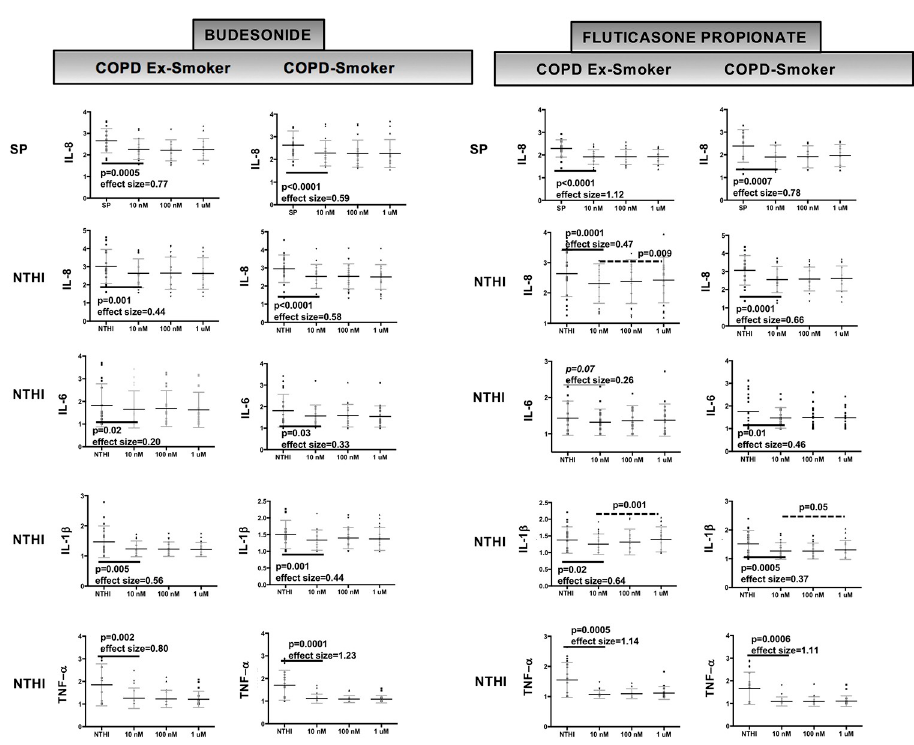
Fig 5. Budesonide and fluticasone propionate both effectively reduced cytokine release from COPD MDMs exposed to NTHI and SP. Analysis of log-transformed data on cytokine concentrations (pg/mL) in MDM-bacteria- ICS co-culture supernatants. The p-values were calculated by paired T-test, assessing the effect of budesonide (BUD) or fluticasone propionate (FP) at 10 nM on NTHI- or SP-induced cytokine release by MDMs from COPD ex-smokers (COPD-ES) and COPD current smokers (COPD-S). Concentration of cytokine released at each concentration of ICS is presented as an aligned dot-plot with thin black bar at the mean, flanking short grey bars delineating the SD. Significant p-values for ICS effect on cytokine release (at 10 nM) and effect size are noted below the thick solid black bars. Only FP inhibition of NTHI-stimulated release of IL-1 β from COPD-ES and COPD-S, and NTHI-stimulated release of IL-8 in COPD-ES demonstrated a statistically significant concentration-response relationship (inverse, greatest suppression at 10 nM) and is denoted by a dashed line over the concentrations with p-value above line. Extent of inhibition of cytokine release was not significantly different between BUD and FP and did not reach EC50 value for any cytokine. Effect size calculated at 10 nM by Cohen’s-d